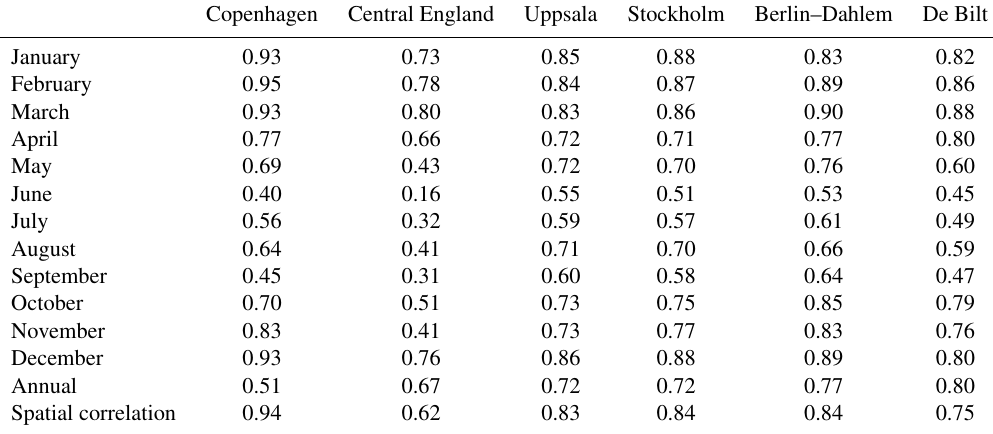
Table A1. Correlations between monthly temperatures in Lund and other network series. Copenhagen Central England